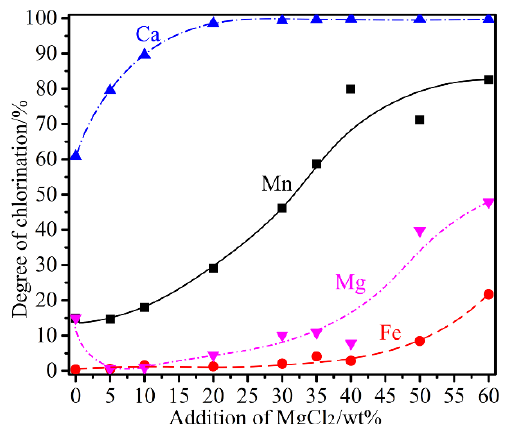
Figure 10. Degree of chlorination vs. the addition of various amounts of MgCl 2 and 20 wt% CaCl 2 before carbothermic reduction.